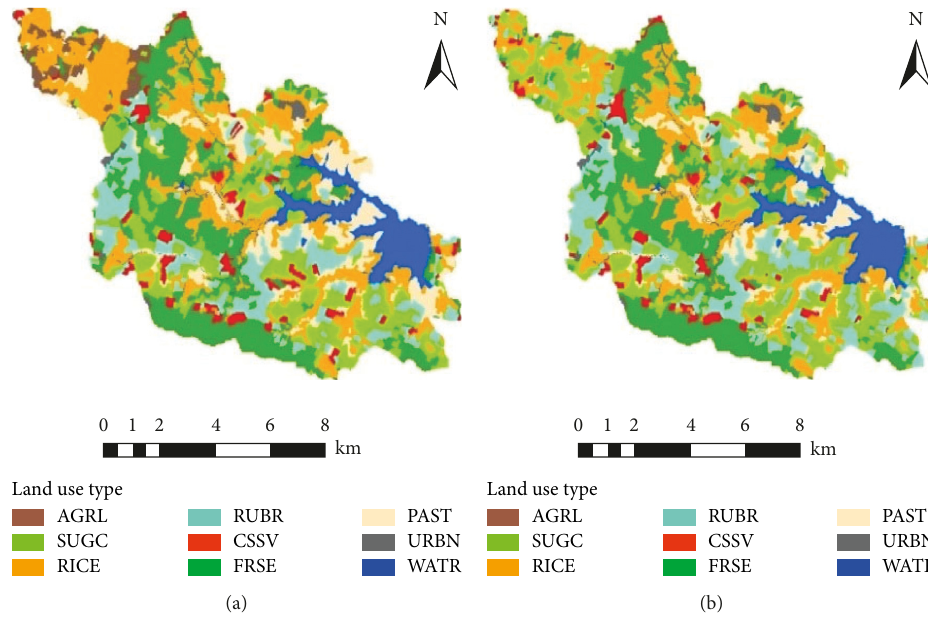
Figure 3: Huay Ling Jone baseline land use maps: (a) year 2010 and (b) year 2015.